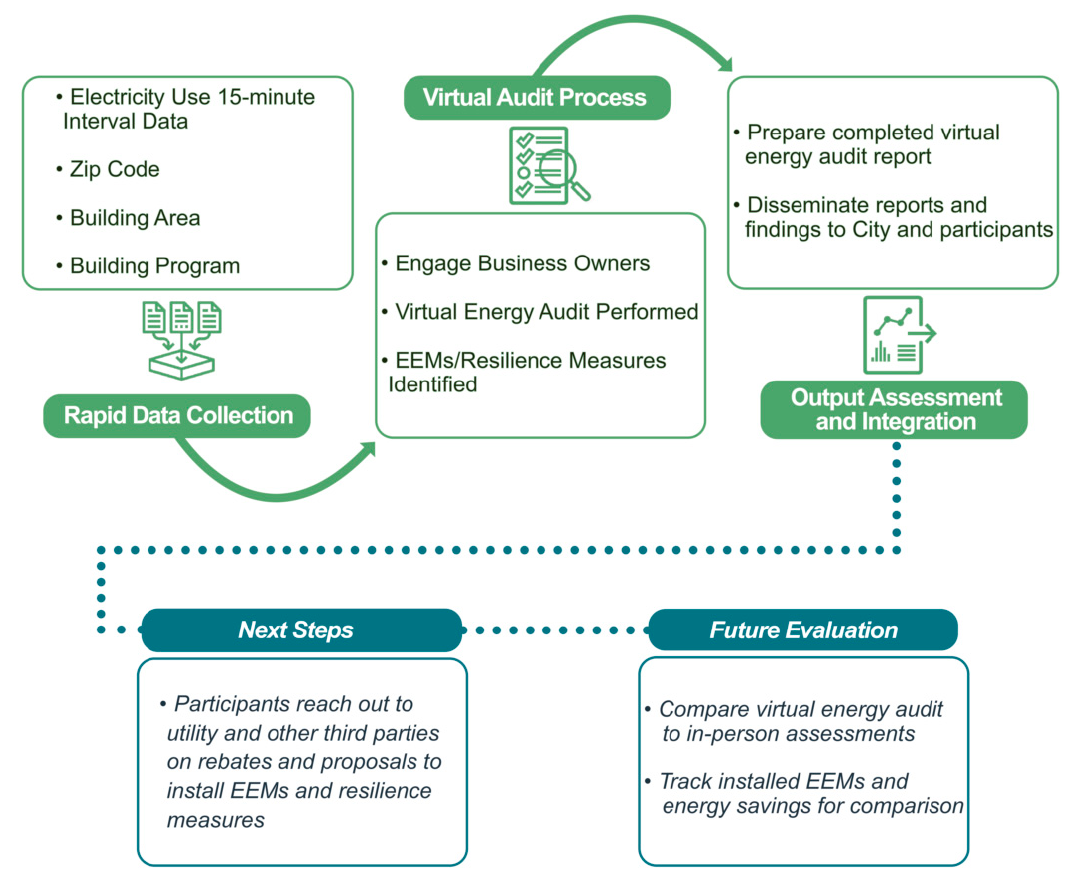
Figure 1. Healthy and Resilient Buildings Initiative Process Flow